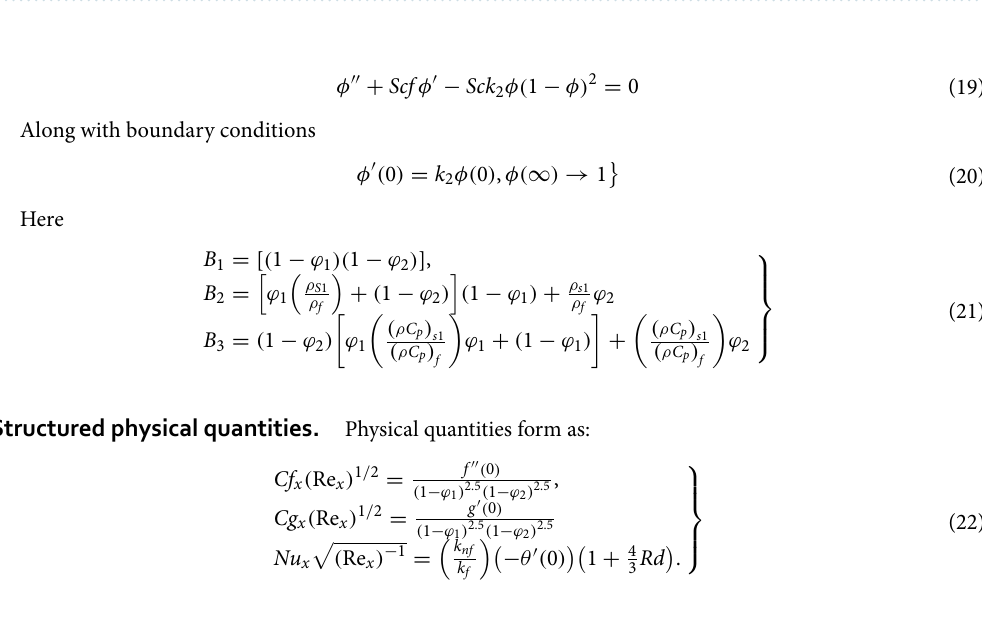
Table 2. briefly examines the validity of the current framework with an existed framework 36 when the values of nanoparticles concentration 0.1 ≤ φ 1 = φ 2 ≤ 0.4 and the rotation parameter 1.0 ≤ (cid:31) ≤ 2.0 for evaluation of f ′′ ( 0 ) and g ′ ( 0 ) with the angle of inclination α = 0 .